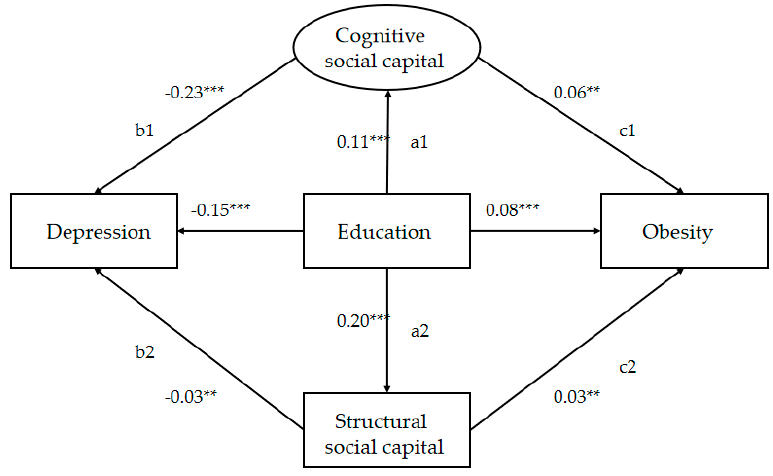
Figure 2. Solution for the structural model ** p < 0.01 *** p < 0.001.